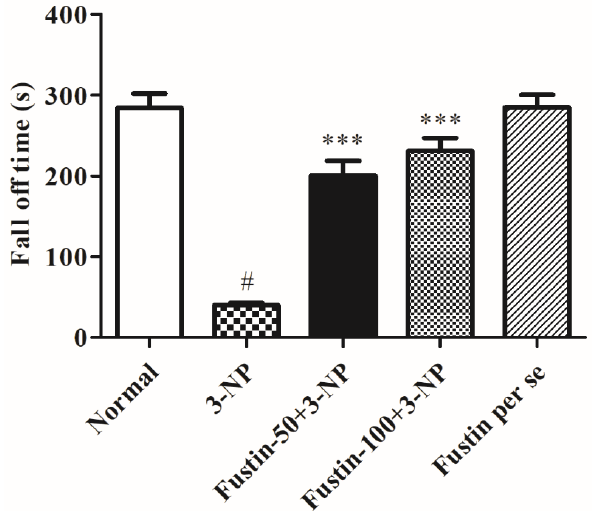
Figure 4. Effect of fustin on rotarod test against 3-nitropropionic acid-induced Huntington’s-like effects in rats. Values are expressed as mean ± S.E.M. ( n = 6). Values are statistically significant at # p < 0.05 vs. negative control group, *** p < 0.001 vs. 3-nitropropionic acid, respectively (Two-way